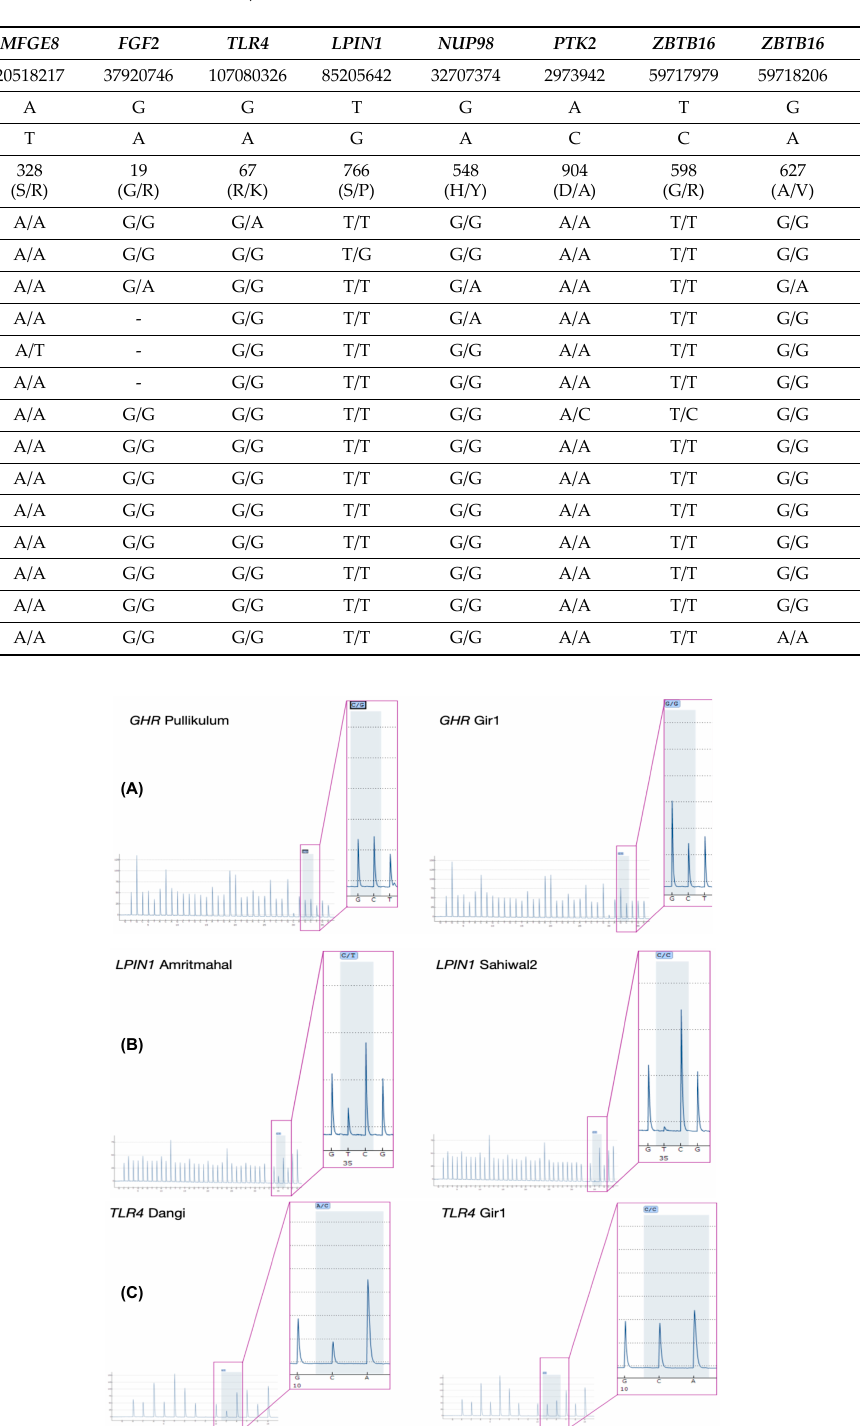
Table 4. Genes with fixed SNP pattern in low‑milk‑yield breeds (Sahiwal and Gir) and respec‑ tive variable SNP pattern in high‑milk‑yield breeds (Gaolao, Deoni, Publicum, Hallikar, Dangi and Amritmahal).